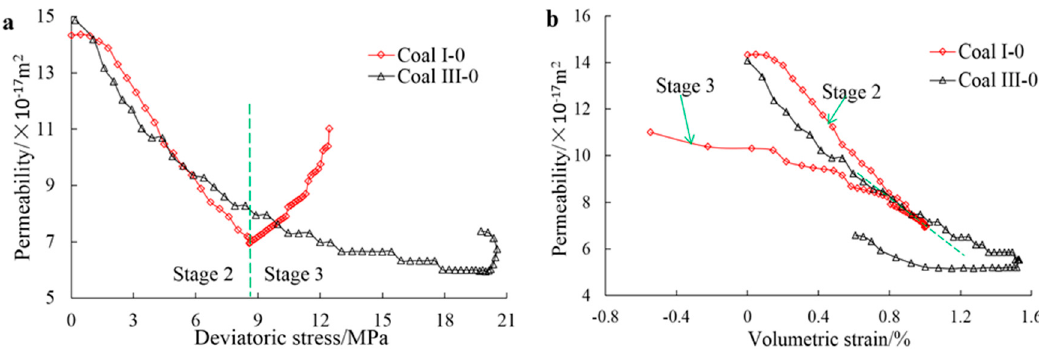
Figure 8. Permeability evolution of coal I-0 and III-0 (Stage 2 and Stage 3 with reference to Stress Path II): ( a ) permeability-deviatoric stress curve; ( b ) permeability-volumetric strain